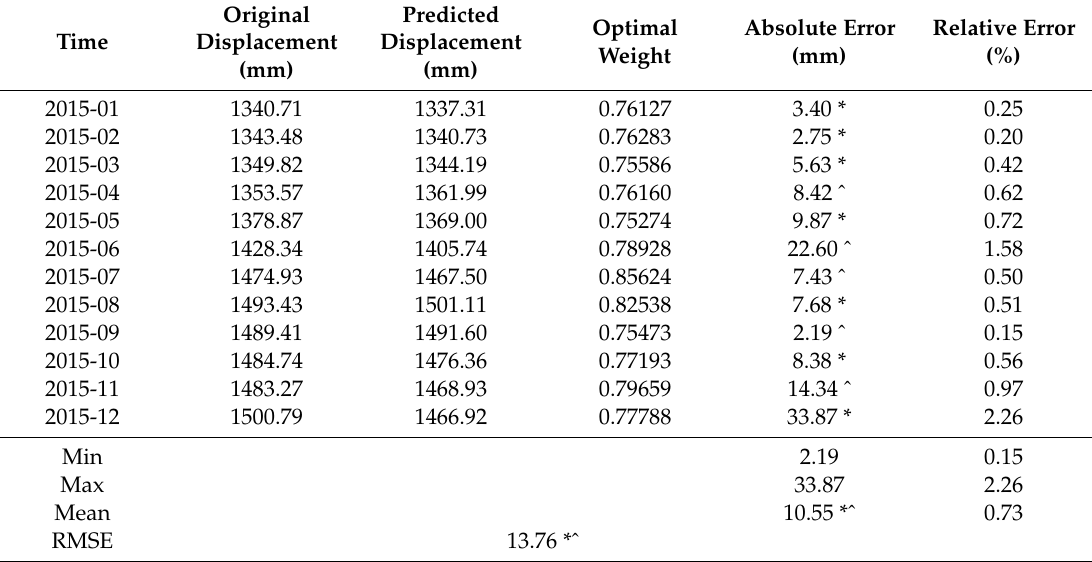
Table 8. Accuracy of the predicted displacement with the Ensemble models of